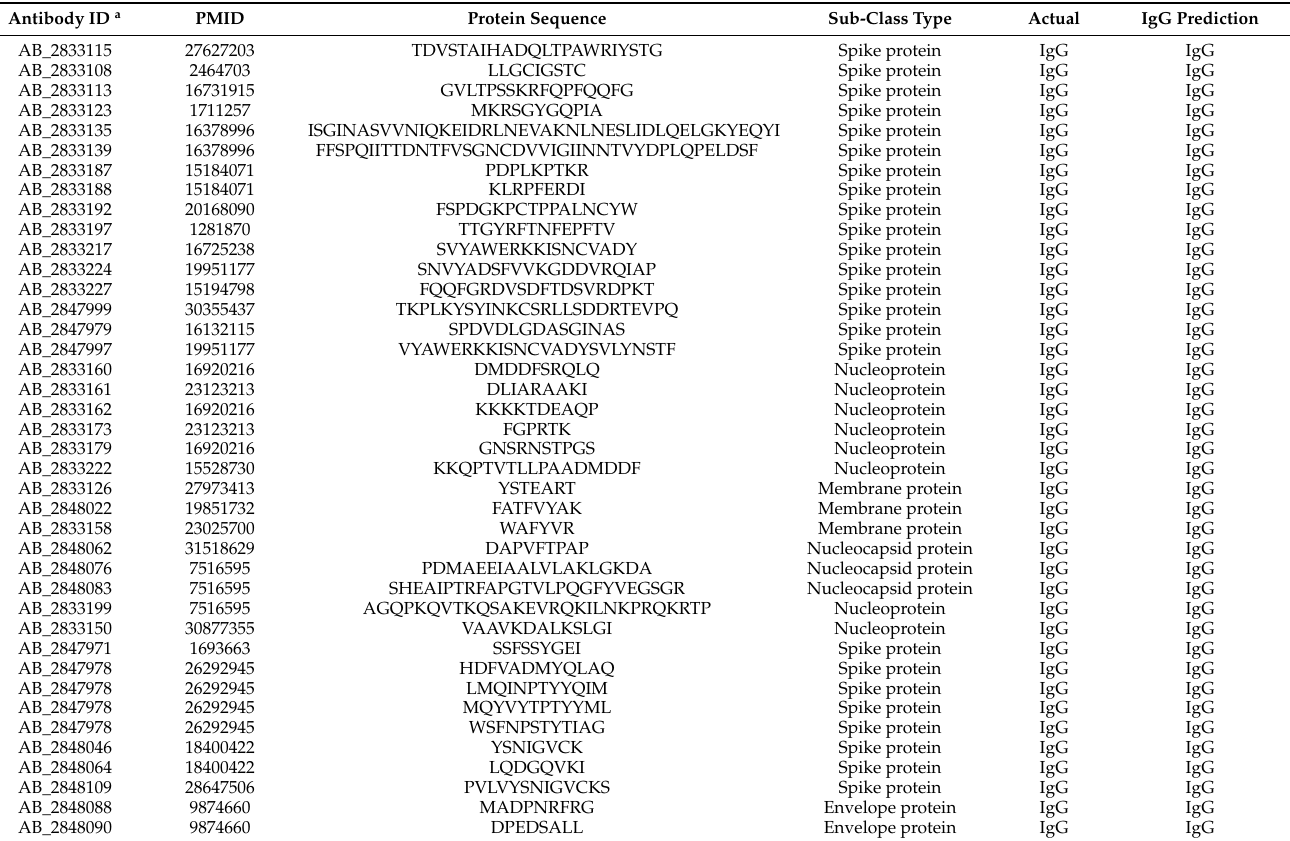
Figure 4. IgG epitopes related to SARS-CoV-2 protein sub-class types. Table 7. List of SARS-CoV-2-related epitopes based on the NIgPred prediction results. Antibody ID a